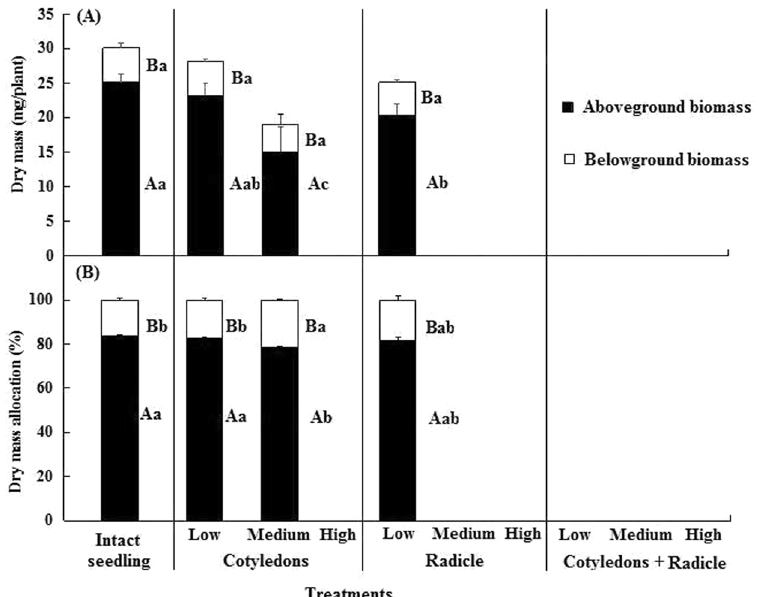
Figure 4. Effect of seed predation class on dry mass accumulation ( A ) and allocation ( B ) (mean + se) in Astragalus lehmannianus seedlings. Intact seedings germinated from scarified seeds and thus neither the cotyledons nor radicle was damaged by predators. In ( A ) and ( B ), different uppercase letters indicate significant differences between aboveground and belowground biomass in the same predation level and different lowercase letters significant differences in aboveground or belowground biomass among the predation classes ( P <